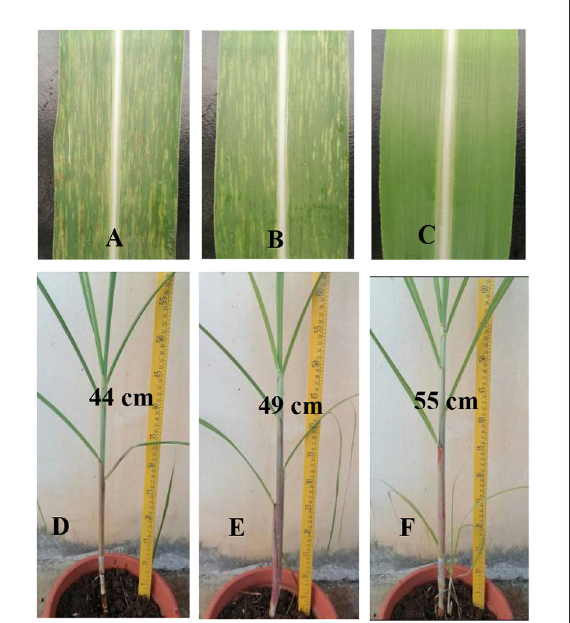
FIGURE6 Phenotypic observation of axillary bud propagation shoots (Three months after transplant in green house). (A) Serious mosaic symptoms on the wild-type shoots’ leaves. (B) Mild mosaic symptoms on the transgenic shoots’ leaves. (C) Normal shoots’ leaves (without SCSMV infection). (D) Wild-type shoots infected by SCSMV were shorter and more slender than transgenic shoots (T5). (E) Transgenic shoots (T5) infected by SCSMV significantly attained greater heights than wild-type shoots but were still significantly shorter than normal shoots. (F) Normal shoots (without SCSMV